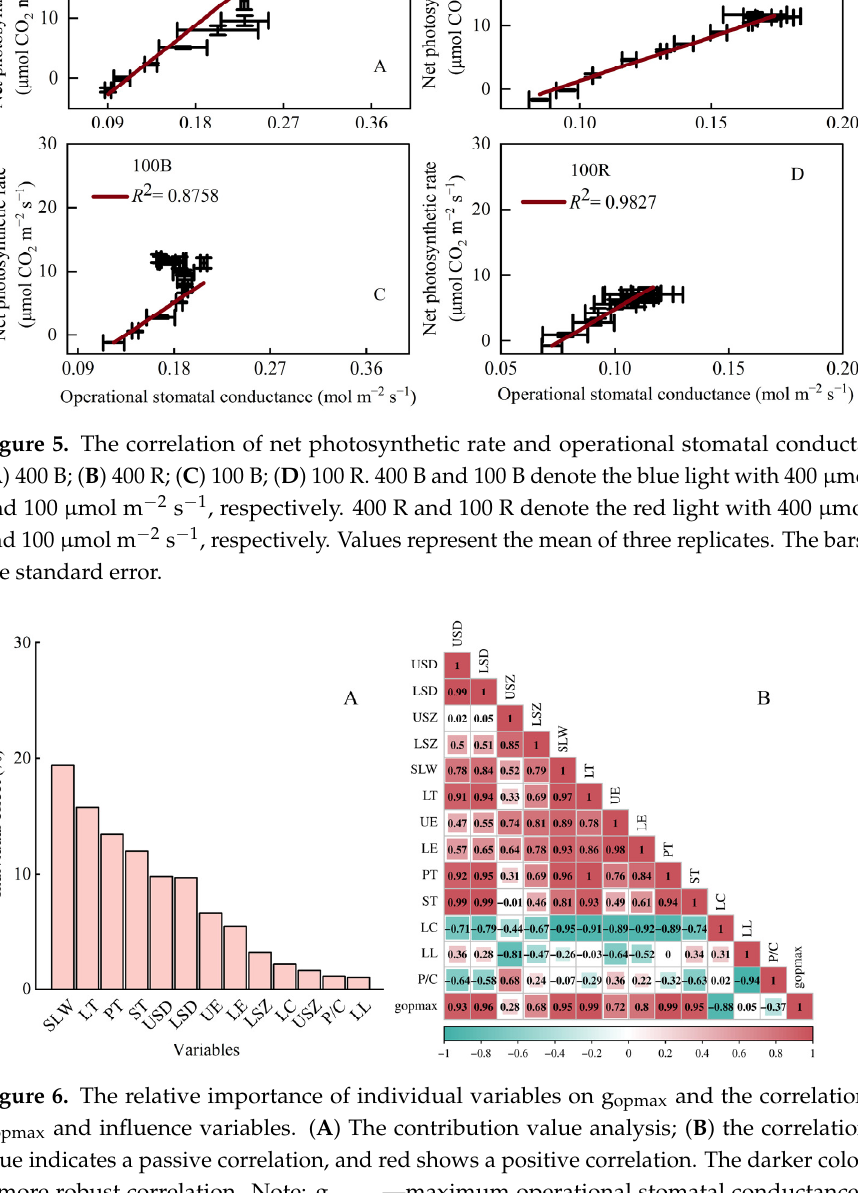
Figure 6. The relative importance of individual variables on g opmax and the correlation between g opmax and influence variables. ( A ) The contribution value analysis; ( B ) the correlation analysis. Blue indi- cates a passive correlation, and red shows a positive correlation. The darker color indicates a more